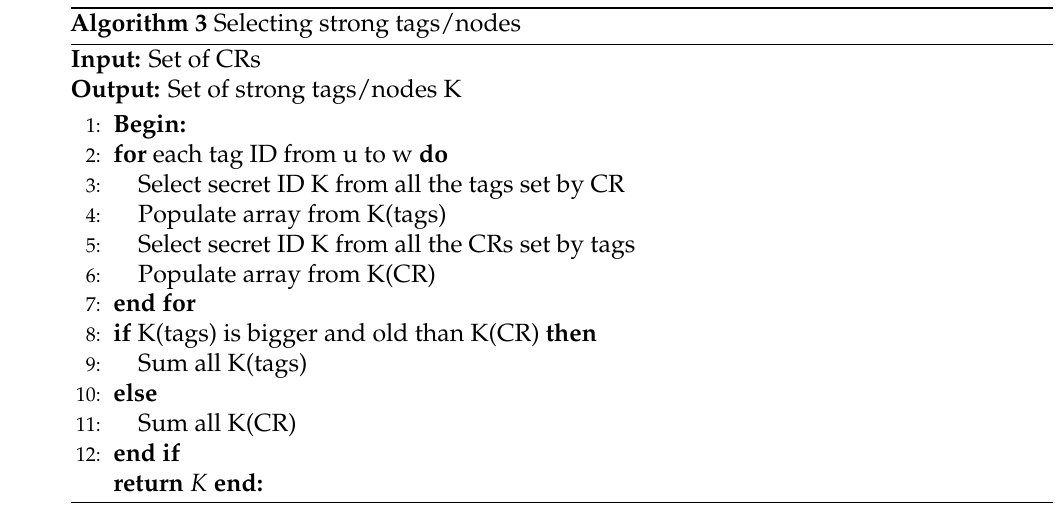
Algorithm 3 Selecting strong tags/nodes